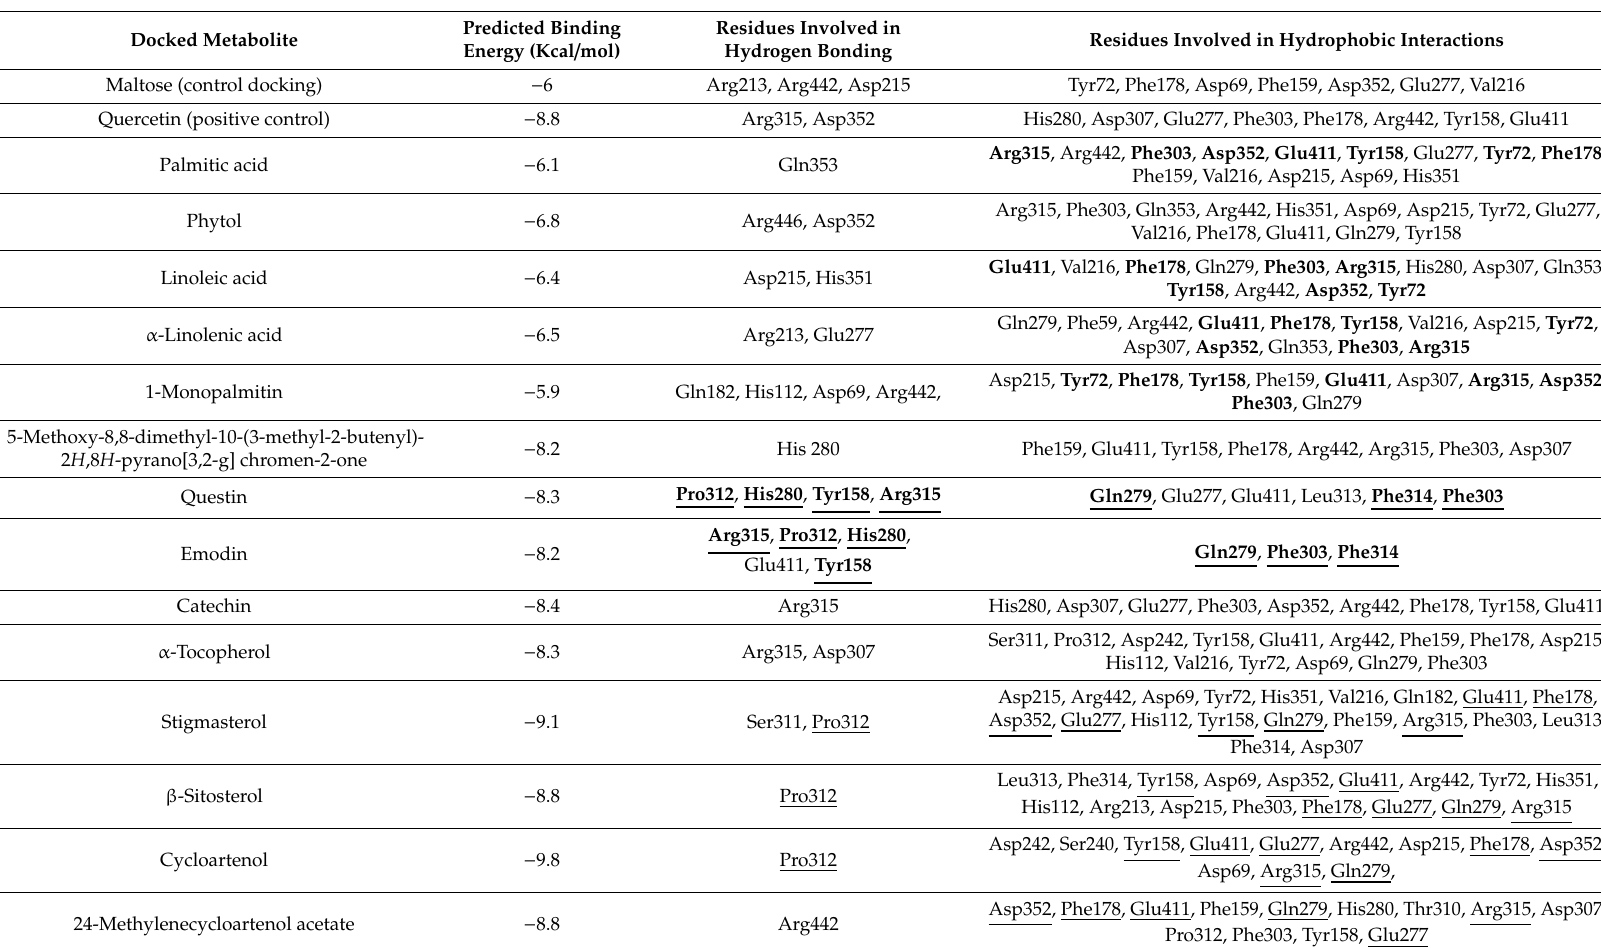
Table 2. Molecular docking results of the identified active metabolites as well as the positive control (quercetin) onto the active site of Saccharomyces cerevisiae isomaltase. Common interacting residues within the same metabolite class (i.e., fatty acids, anthraquinones and phytosterols) are highlighted by bold and / or